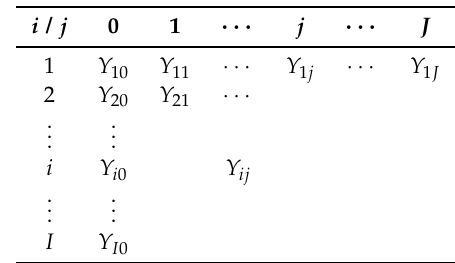
Table 1. Run-off triangle of cumulative